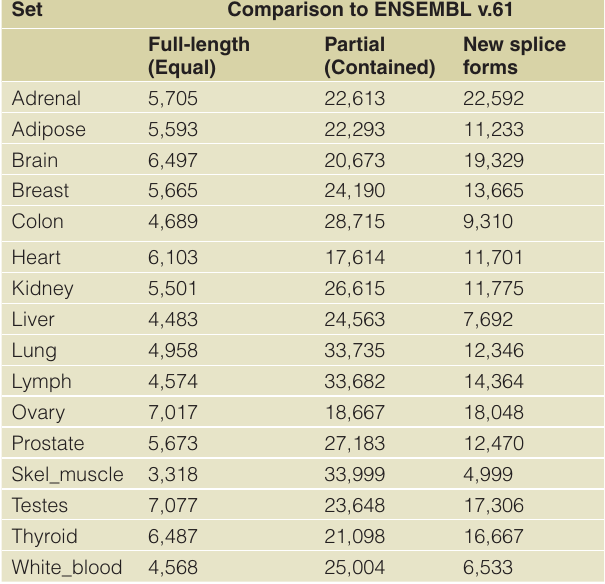
Table S4. Novel and known gene splice forms in the sixteen tissues, determined by comparison to the ENSEMBL v.61 annotation database using the program Cuffcompare. Cuffcompare compares each predicted transcript’s intron chain against those of the reference transcripts and classifies the transfrag as: ‘equal’ to a reference transcript, if their intron chains are identical; ‘contained’ , if included in a reference transcript’s; or as a ‘new splice form’ , if the intron chain has at least one splice junction in common with the reference transcripts (n.b., other Cuffcompare codes are not relevant and were omitted). Set Comparison to ENSEMBL v.61